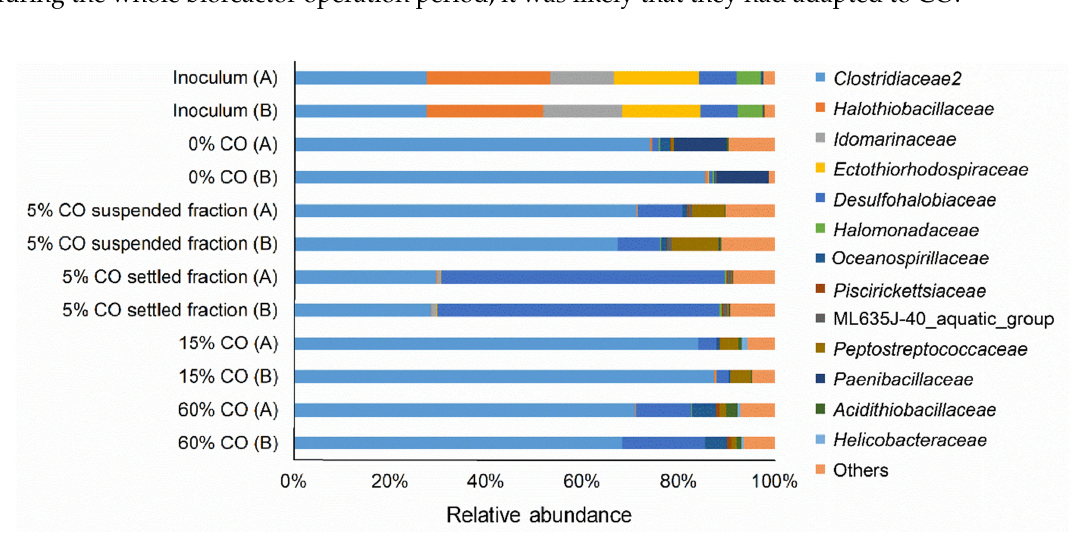
Figure 6. Microbial 16S rRNA relative abundance on family level in the inoculum and biomass samples from the end of the runs without CO (day 46), with 5% CO (day 123), with 15% CO (day 216), and after the spike with 60% CO (day 218). For the samples of day 123, the suspended and settling fractions were separated and analyzed separately. A and B represent duplicates for the corresponding day. OTUs with less than 0.5% relative abundance were grouped in “others.”